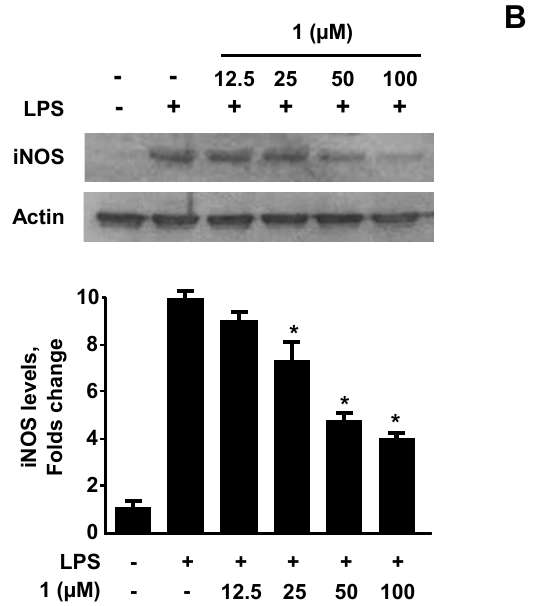
Figure 4. Effect of neoechinulin A ( 1 ) on the expression of iNOS (A) and COX-2 (B) protein. RAW264.7 macrophages were pre-treated with the indicated concentrations of neoechinulin A ( 1 ) for 3 h, and then treated with LPS (1 μ g/mL) for 18 h. Representative blots from three independent experiments with similar results and densitometric evaluations are shown. Data shown represent the mean values of three experiments ± SD. * p < 0.05 as compared to the group treated with LPS